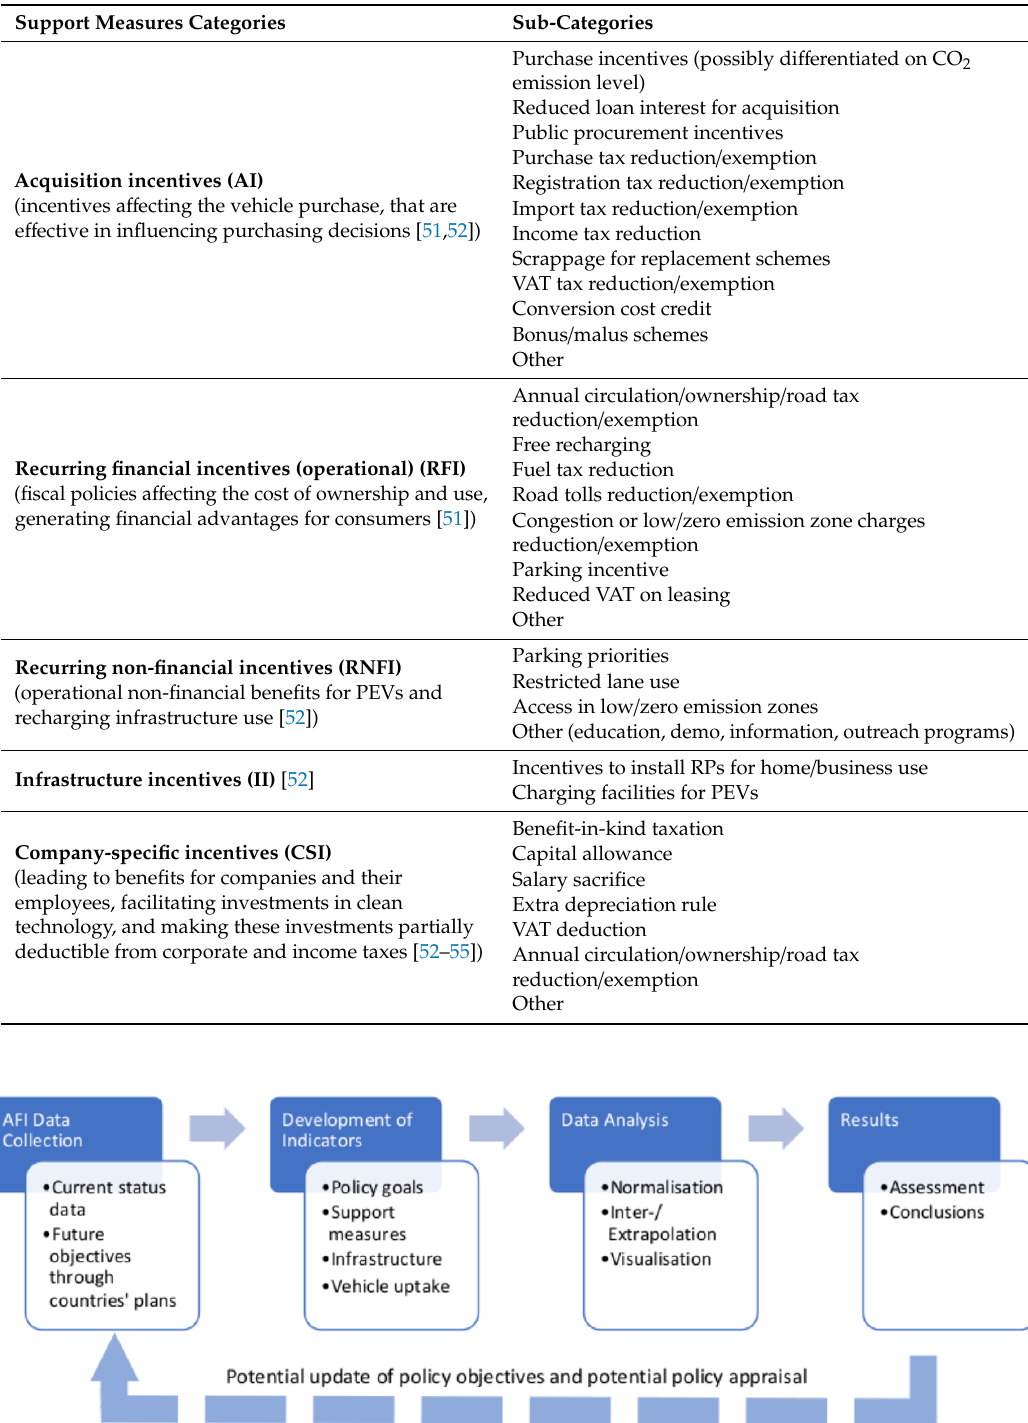
Table 1. Proposed classification of support measures.